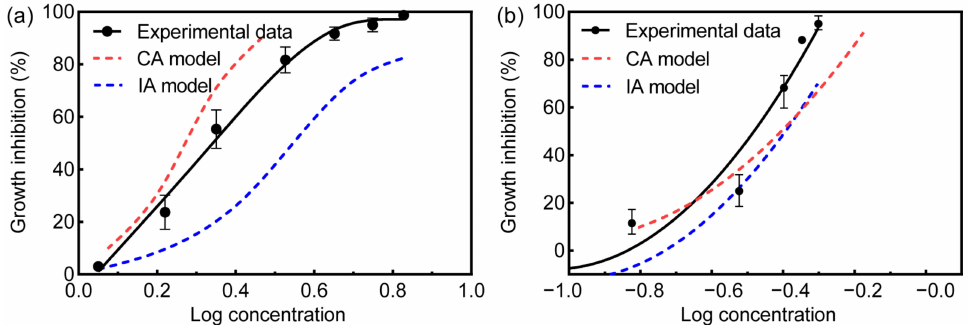
Figure 1. The comparison of experimental data (( a ) SMX + SMZ and ( b ) SMX + ERY) and the predicted dose-response curves. Error bars represent SD ±